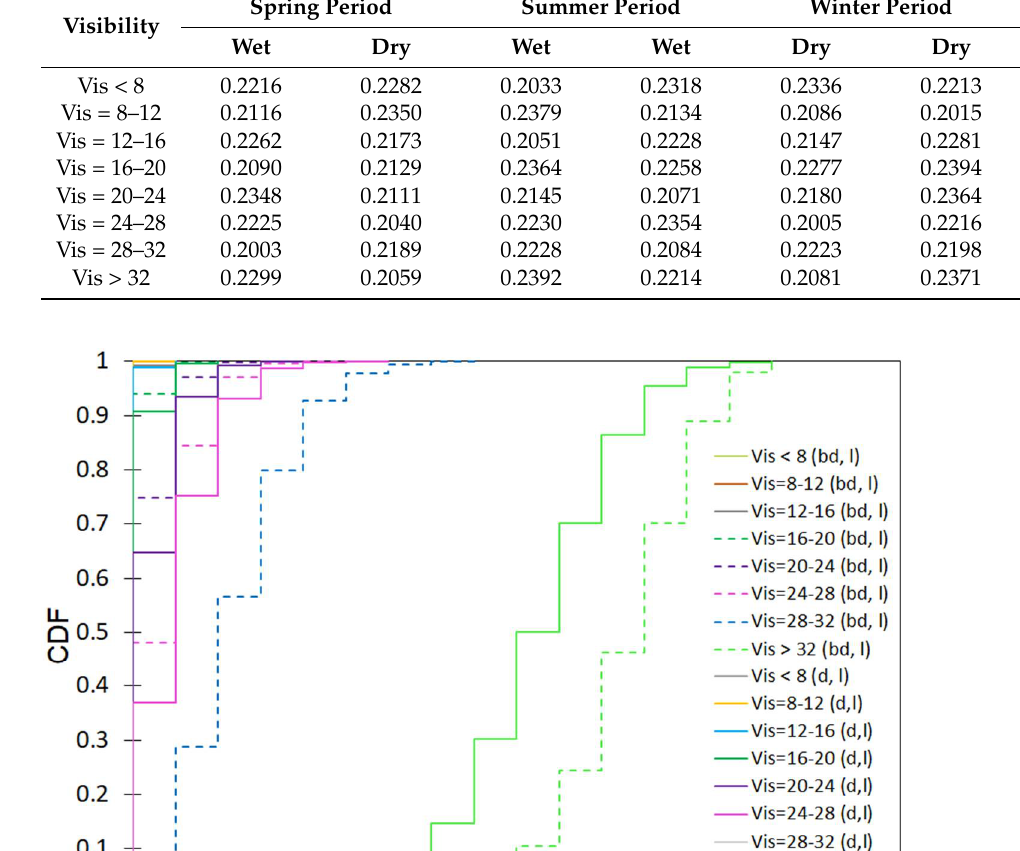
Figure A2. Number of days (D z ) with visibility in the respective range of variability for the period rain and no rain for the spring season.